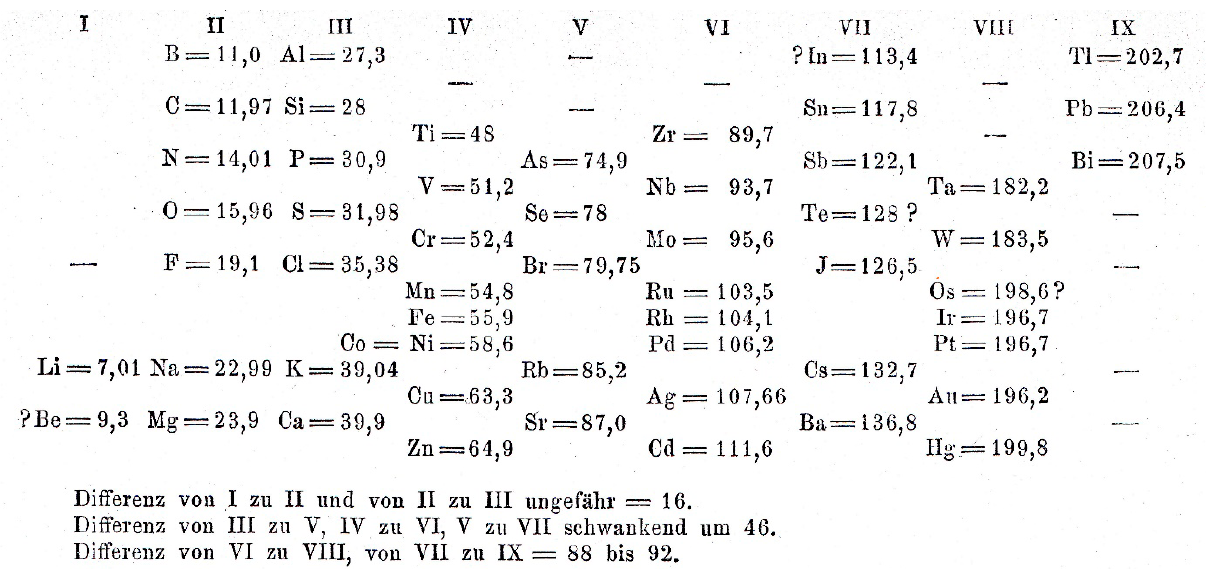
Figure 6. Meyer‘s classification of elements from 1870. Scan from K. Seubert, Das natürliche System der chemischen Elemente . 2 nd edition, Engelmann, Leipzig, 1913,